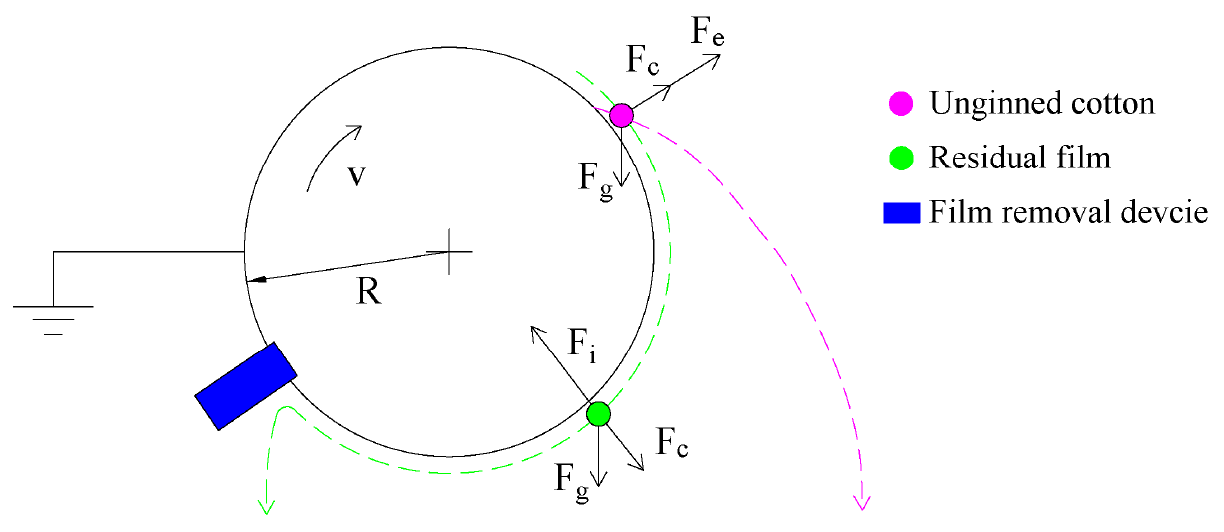
Figure 5. Schematic diagram showing the material forces and motion trajectory.